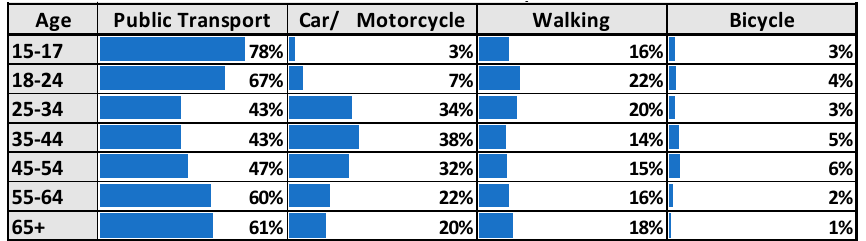
Figure 9. Portion of commuting by different means of transport according to age.